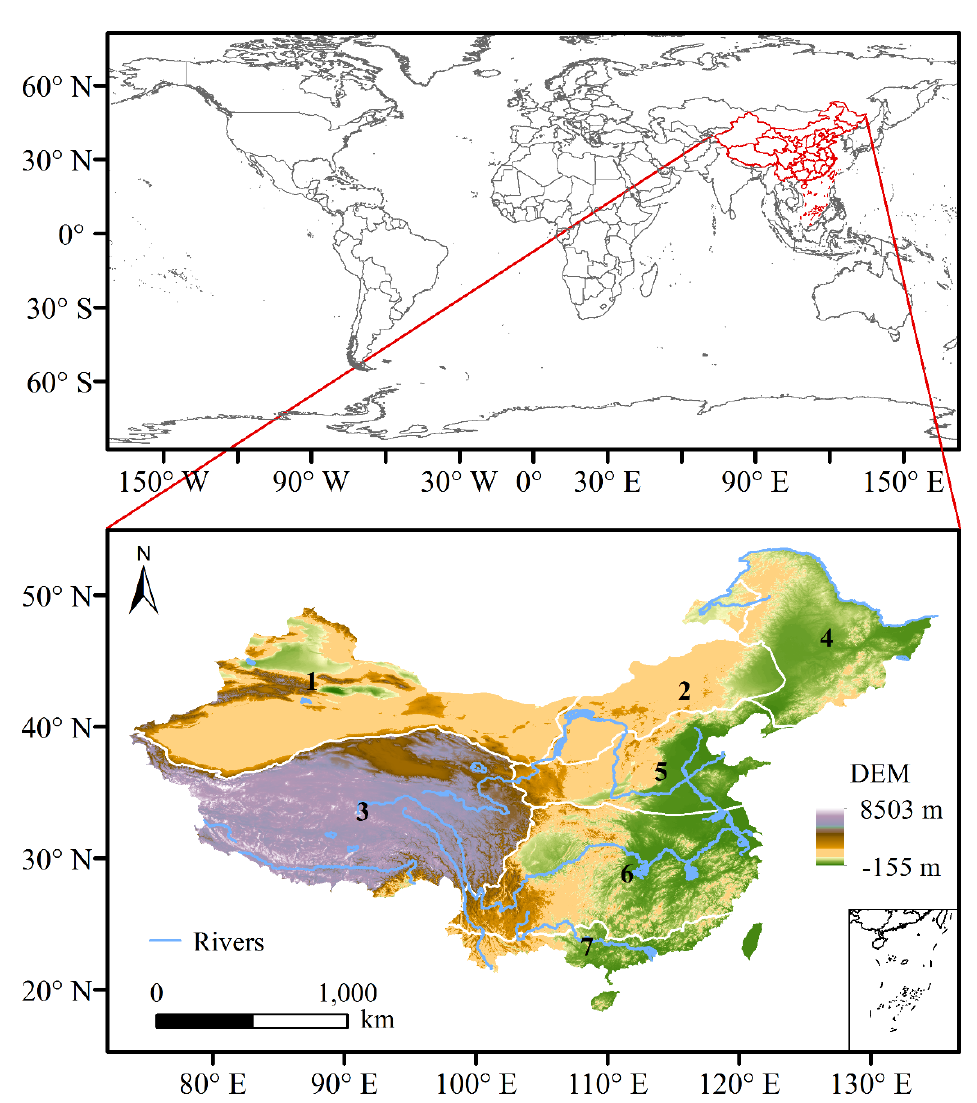
Figure 1. Map of elevation and climatic sub-regions in China. The white lines are boundaries of neighboring sub-regions. The Arabic numerals denote different sub-regions.